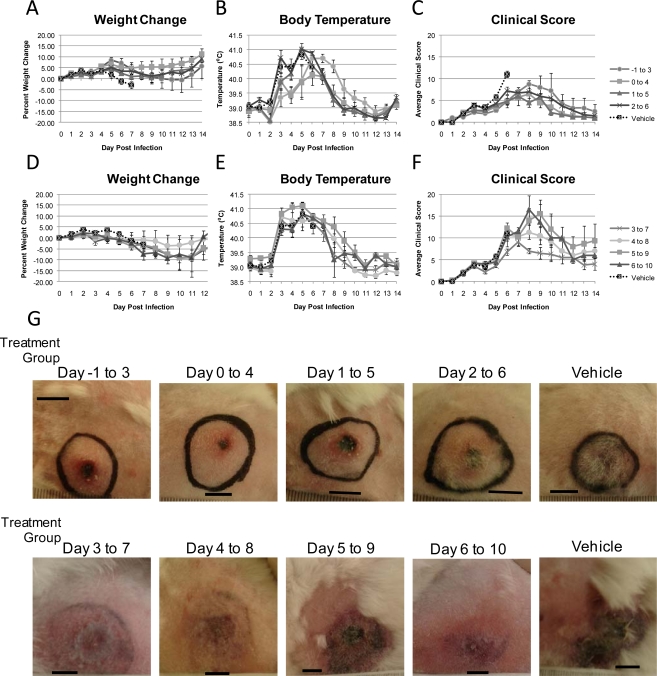
Clinical observations for evaluation of survival when dosage with CMX001 is delayed up to six days post infection. Animals were dosed at concentrations and schedules as outlined in Table 3. (A) Average weight change from weight at day of infection. Negative values indicated weight loss (B) Average body temperatures. (C) Average clinical scores. The higher the number, the more severe the disease presentation. (D) Pictures of primary lesions from representative animals at 6 or 7 dpi. Bars represent 1 cm. Black circles denote site of intradermal inoculation.